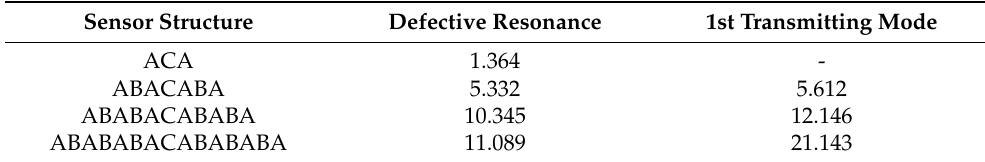
Figure 6. The transmittance spectra of the 15-layer defective MPC sensor with a salinity range of ( a ) 0–5‰, ( b ) 5–30‰. Table 1. Quasi- and quality factors of the defective resonance and first transmitting mode for the four detective MPC sensors under DI water configured within the defective